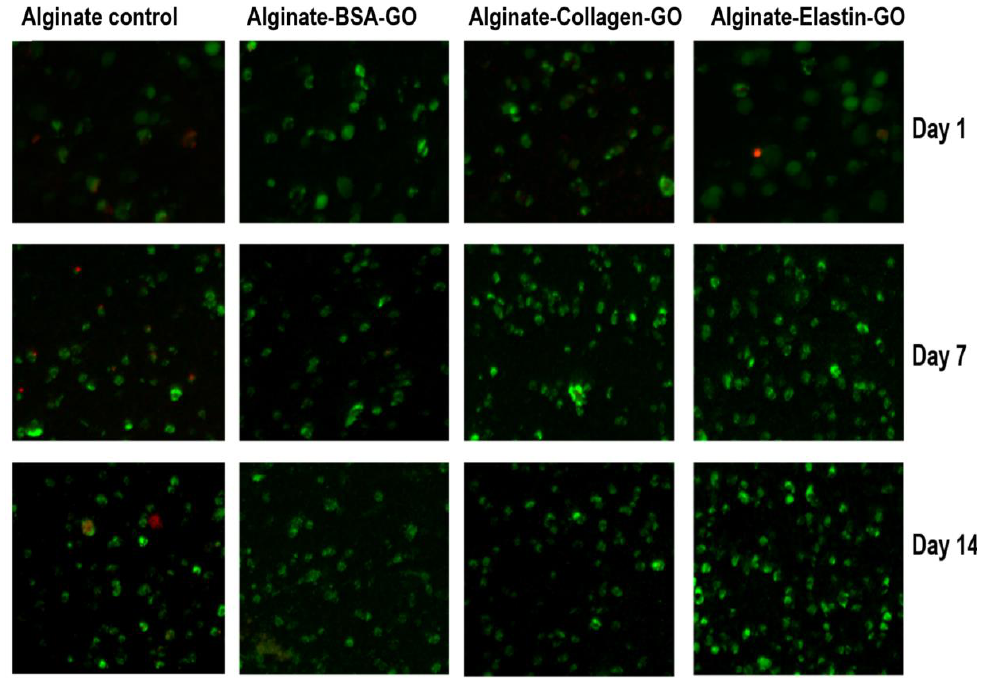
Figure 9. Fluorescence microscopy images, after calcein/ethidium staining for C 2 C 12 – EPO myoblasts incorporated within the modified alginate hydrogels based on GO-BSA, GO-collagen and GO-elastin matrices. Green: live cells. Red: dead cells. Scale bar: 100 µm.